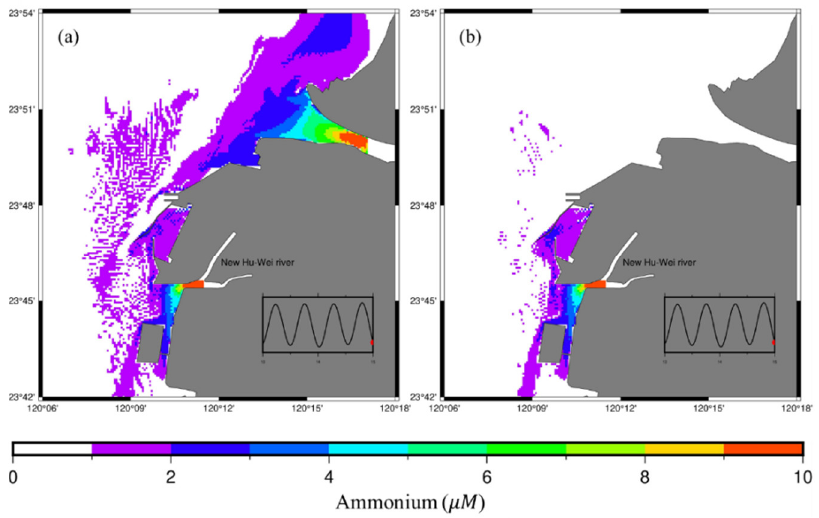
Figure 12. During the ebb, low slack water in the ammonium concentration ( a ) with the CS river and ( b ) without the CS river. A small insert at the lower-right corner indicates the tidal phase.